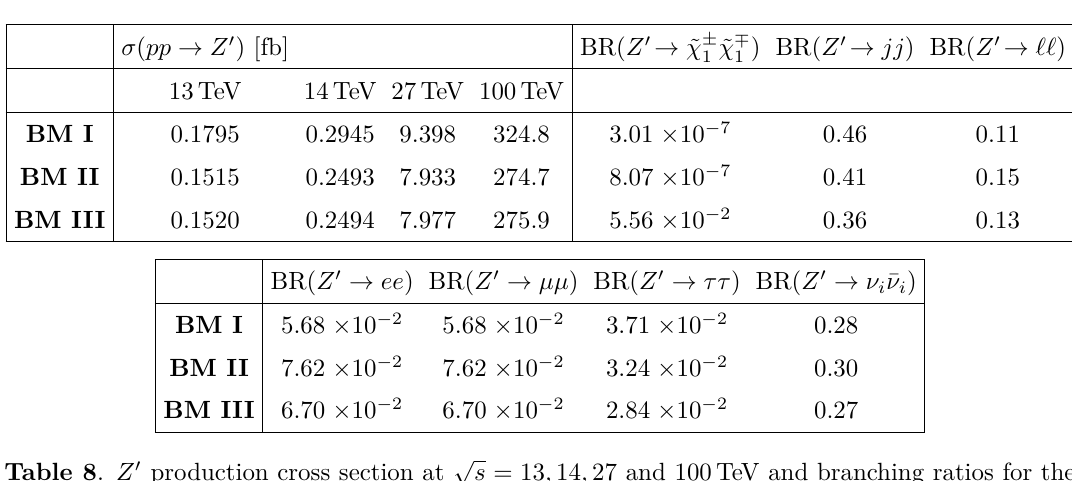
Table 8 . Z 0 production cross section at